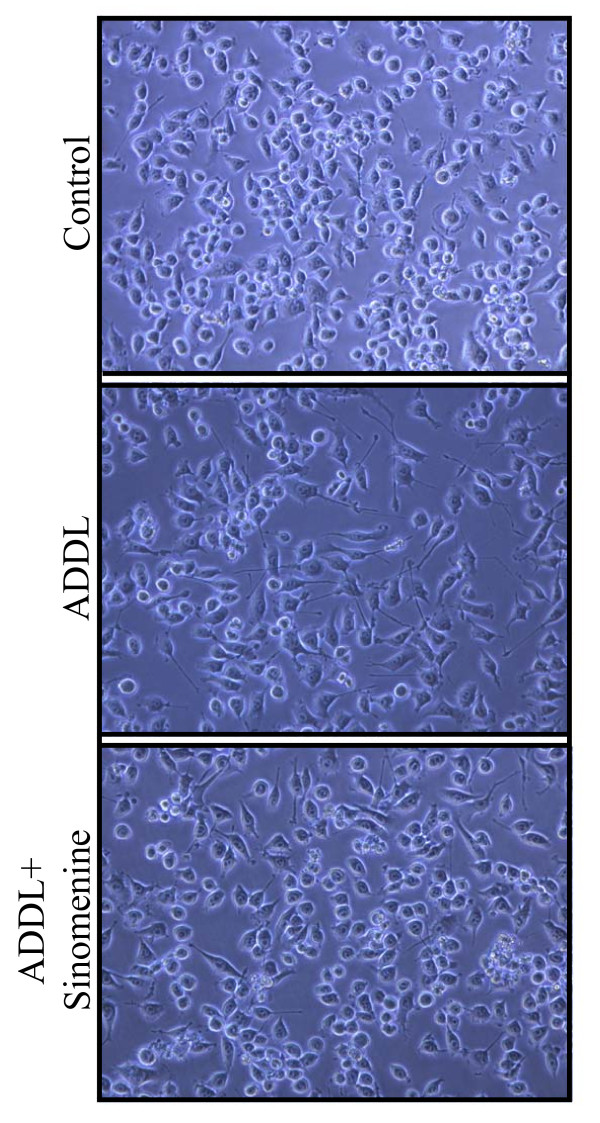
Sinomenine inhibits morphological changes induced by oligomeric amyloid-β. Phase contrast images (20× magnification) of BV2 cells treated with oligomeric Aβ (ADDL) in the presence or absence of sinomenine show that ADDL treatment led to extended processes and elongated morphology of the cells, but sinomenine reduced these ADDL-induced morphological changes.